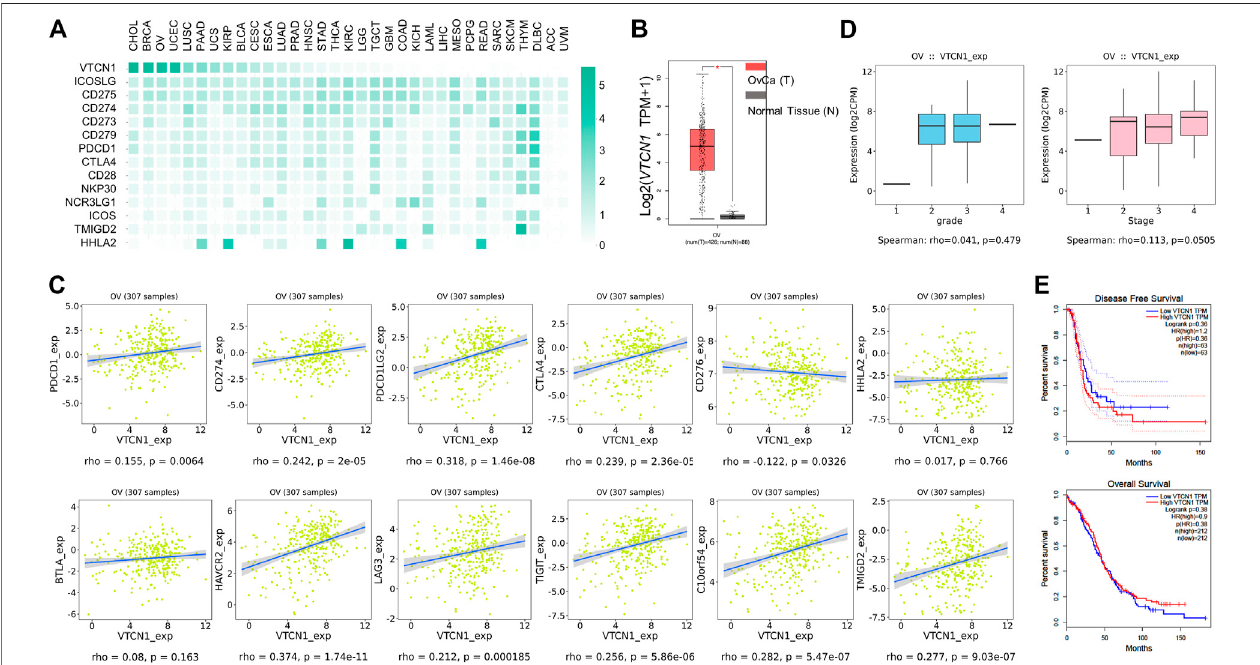
FIGURE 1 | VTCN1 was overexpressed in OvCa and correlated with multiple co-inhibitory immune checkpoint genes. (A) Heatmap analysis of the mRNA expressionofB7/CD28familygenesinvarioushumantumors,shownasscaledlog2-foldchanges(GEPIAdata). (B) Theexpressionlevelsof VTCN1 inhumanOvCaand normal controls. The data were derived from TCGA database and are shown on a log2 (TPM +1) scale. TPM: transcripts per million. The p value cutoff was 0.01. * p < 0.05. (C) Correlationsof VTCN1 expressionwithtumorgrade(left)andstage(right)inpatientswithOvCa. (D) Correlationsof VTCN1 expressionwiththemRNA expression levels of several immune checkpoint proteins. (E) Correlations of VTCN1 expression with disease-free survival (upper panel) and overall survival (bottom panel) in patients with OvCa.